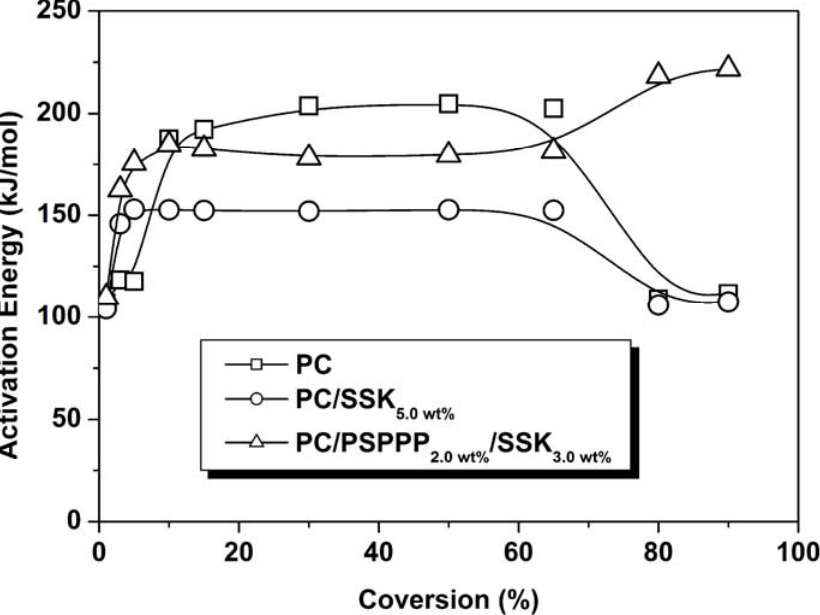
Figure 1. Activation energy ( E according to Flynn method